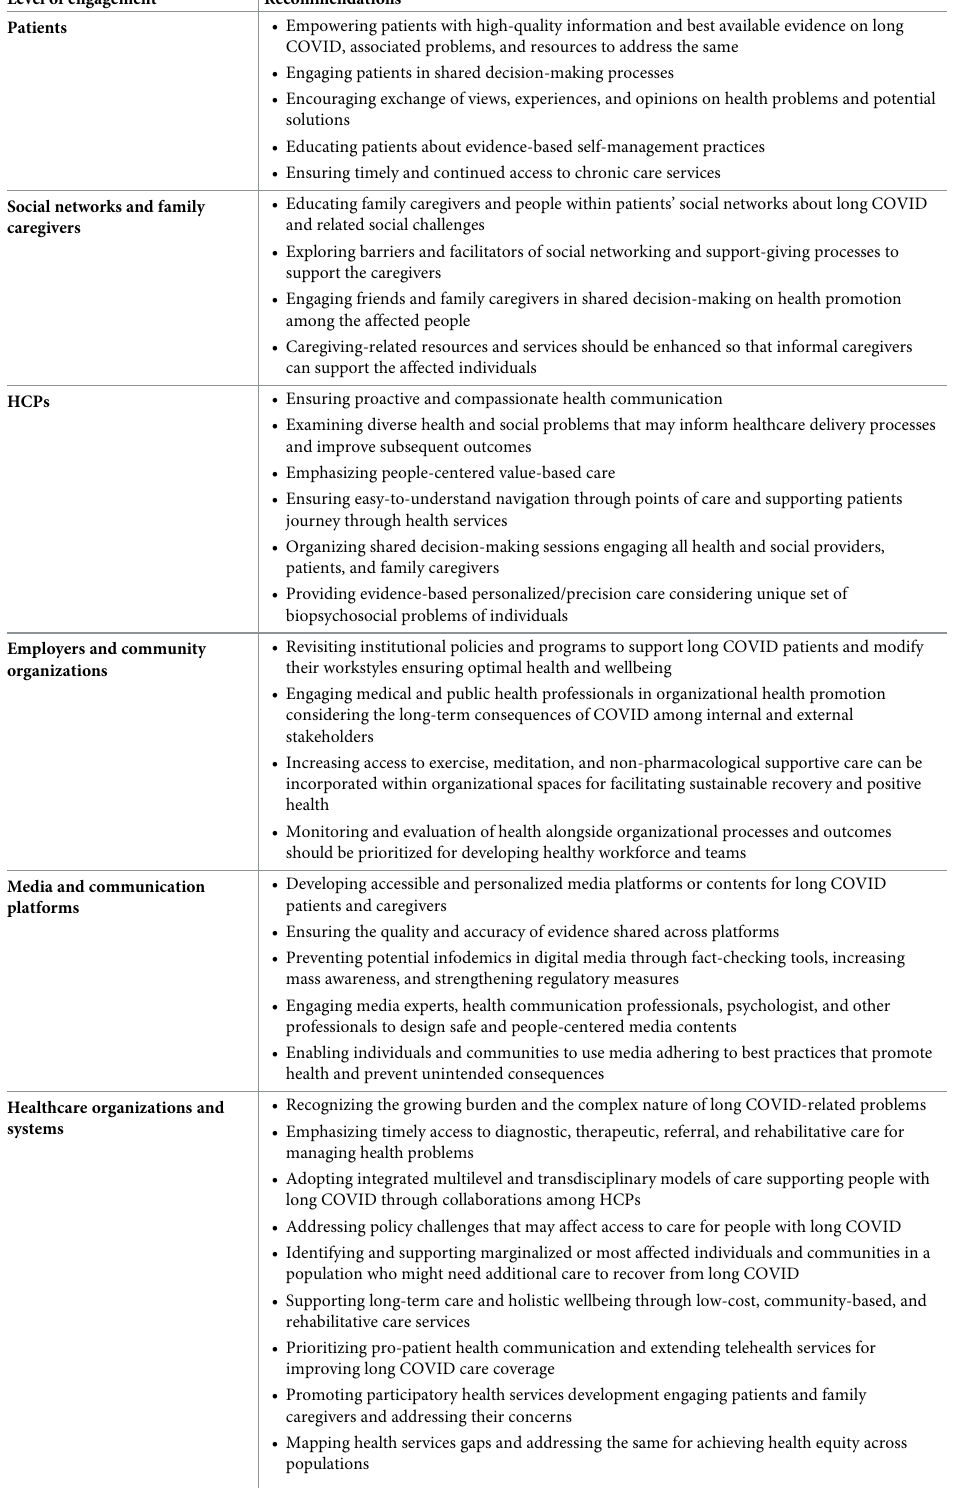
Table 9. Multilevel recommendations for health promotion in people with long